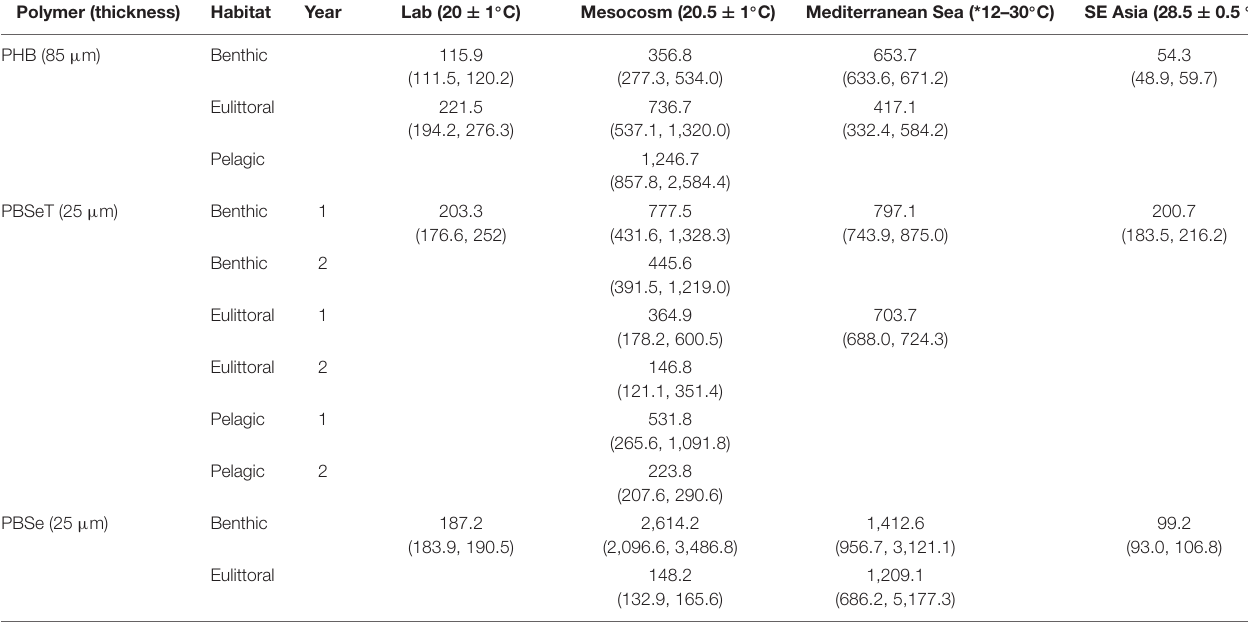
TABLE 3 | Summary of all tests: Half-lives t 0 . 5 of PHB, PBSe, and PBSeT as predicted by statistical modeling of the experimental data. Polymer